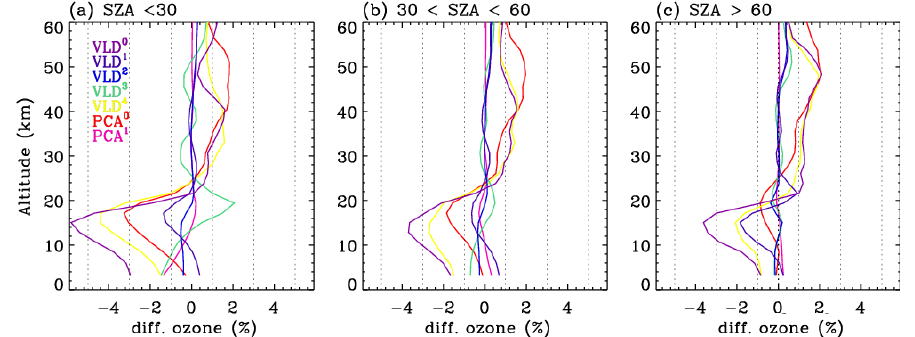
Figure 9. Mean biases of ozone profile retrievals with different configurations compared to those with the reference configuration. Each configuration is given in Table